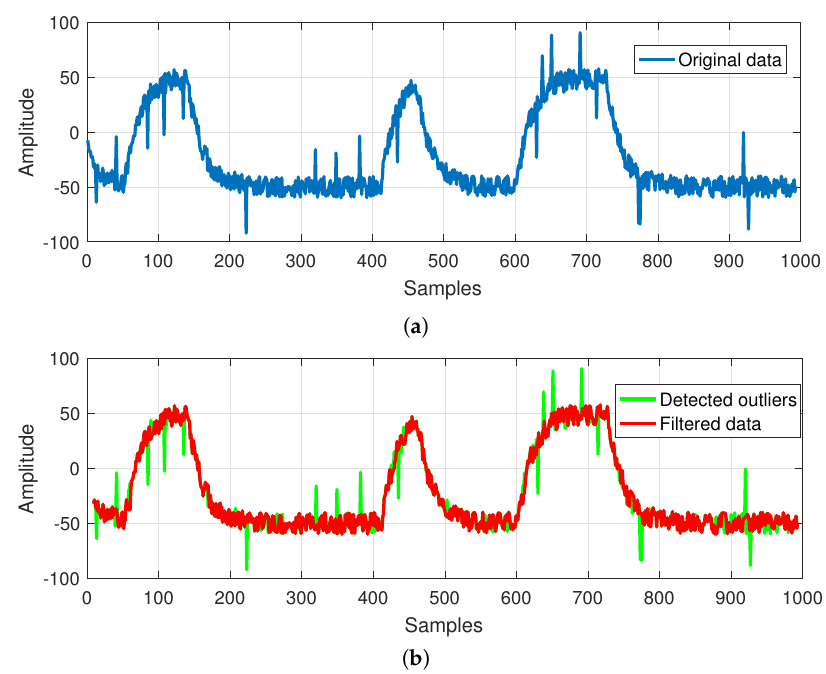
Figure 7. Simulations by using wavelet algorithms without a priori knowledge on the noise. ( a ) data with artificial outliers; ( b ) outliers correctly detected.